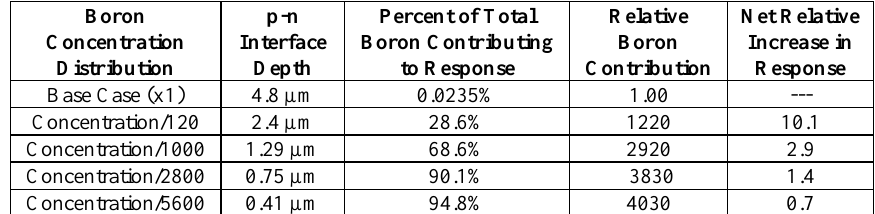
Table 2. Relative SiC p-n Detector Thermal-Neutron Sensitivities as a Function of Amount of boron Diffused into the Detector